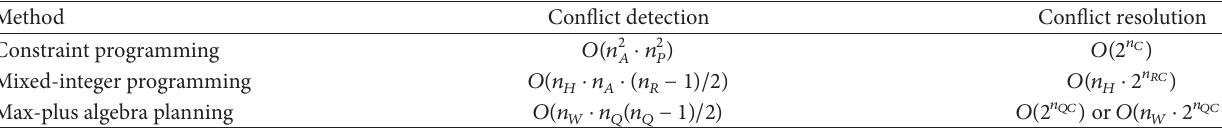
Table 5: Comparison of computational complexities of different